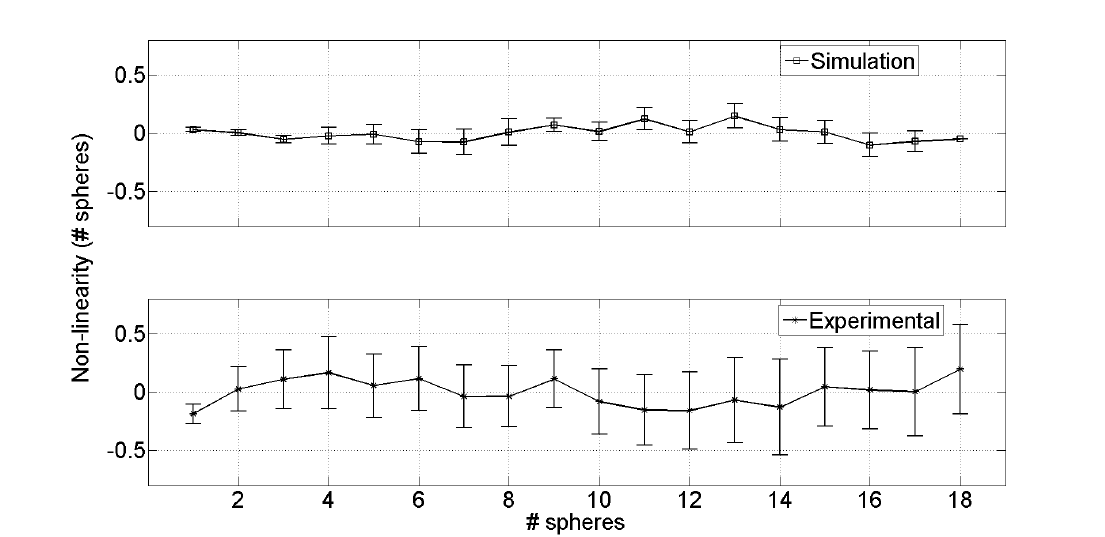
Figure 7. Evaluation of the non-linearity on the measurement expressed in terms of number of spheres (one sphere is 1.77 × 10 − 9 m 3 ). Top graph represents the simulations, bottom graph represents experimental results. Error bars are the uncertainty expressed as standard deviation of the sample